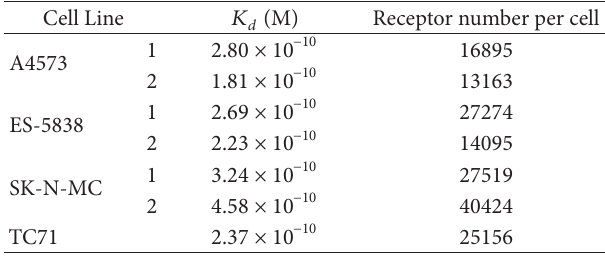
T 1: Ligand-binding displacement quanti�cation of IGF-1R surface expression in ES cell lines. e column adjacent to cell line names refers to replicate experiments.